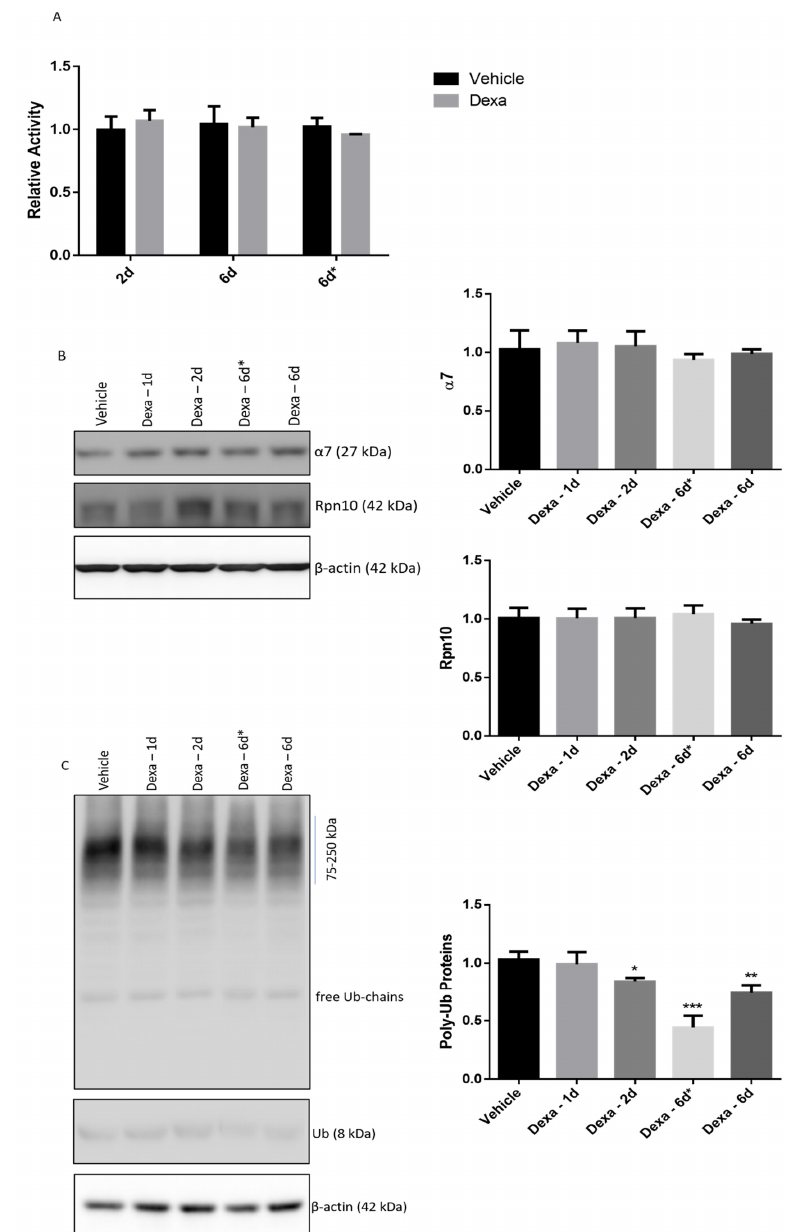
Figure 2. Proteasome activity is not significantly altered by Dexa treatment. ( A ) Protea- some assemblies of crude cell extracts of TMCs were assayed for the kinetics of LLVY-amc cleavage. The release of fluorescence ( λ exc. : 380 nm; λ em. : 460 nm) was monitored until linearity was observed (typically 2 h). Individual slopes were calculated by subtracting the fluorescence release in the presence of 500 nM epoxomicin (null). Data are presented as fold variation of the slope between Dexa and correspondent vehicle-treated cells. A nominal value of 1 was assigned to the slope calculated for the first (1 out of 3 wells) vehicle cells. Comparisons have been run between Dexa and correspondent vehicle cells at each timepoint. ( B ) Immunodetection of α 7 and Rpn10 subunits and ( C ) ubiquitinated proteins by denaturing and reducing Wb in whole cell lysates. β -actin was used as internal control. Notably, ( C ) has been manipulated to clear out one lane loaded with an additional vehicle cell lysate. * p < 0.04; ** p < 0.005; *** p < 0.0001. A representative experiment of three independent observations is reported ( n = 3); one-way ANOVA followed by Tukey’s post hoc significance